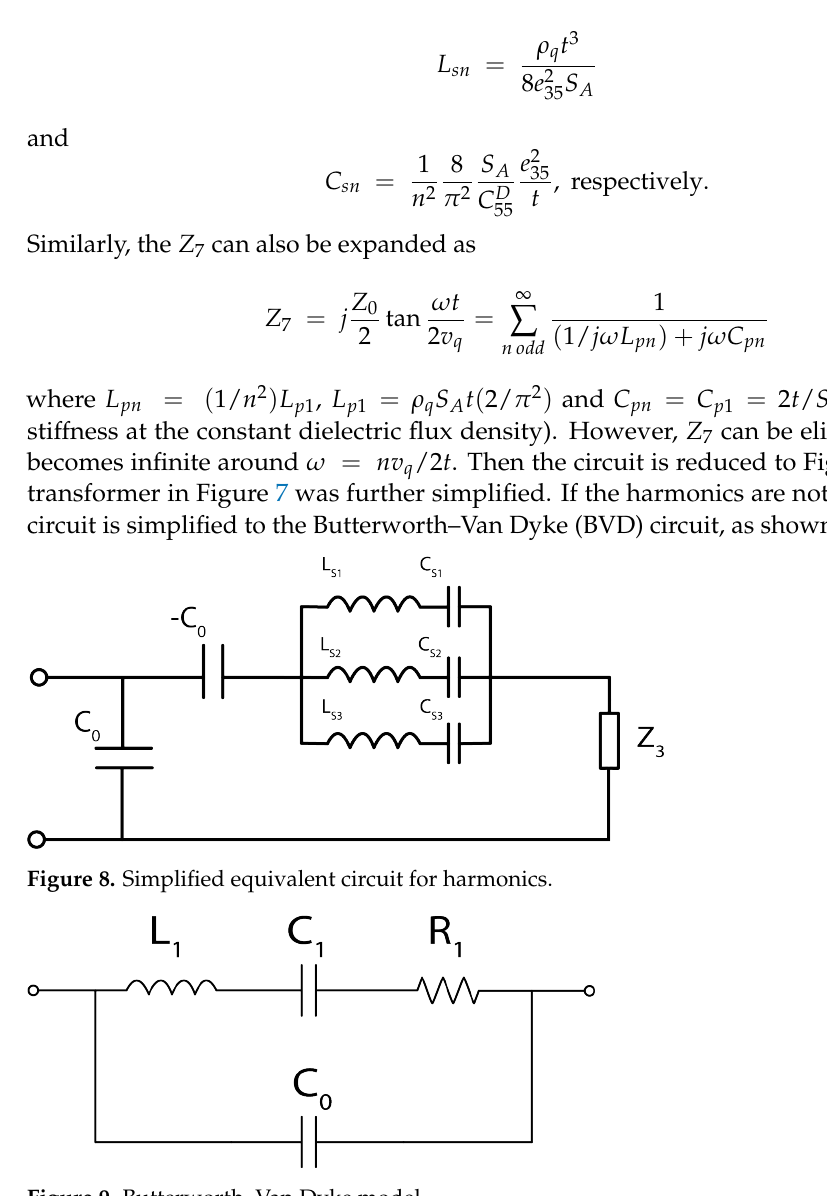
Figure 9. Butterworth–Van Dyke model.